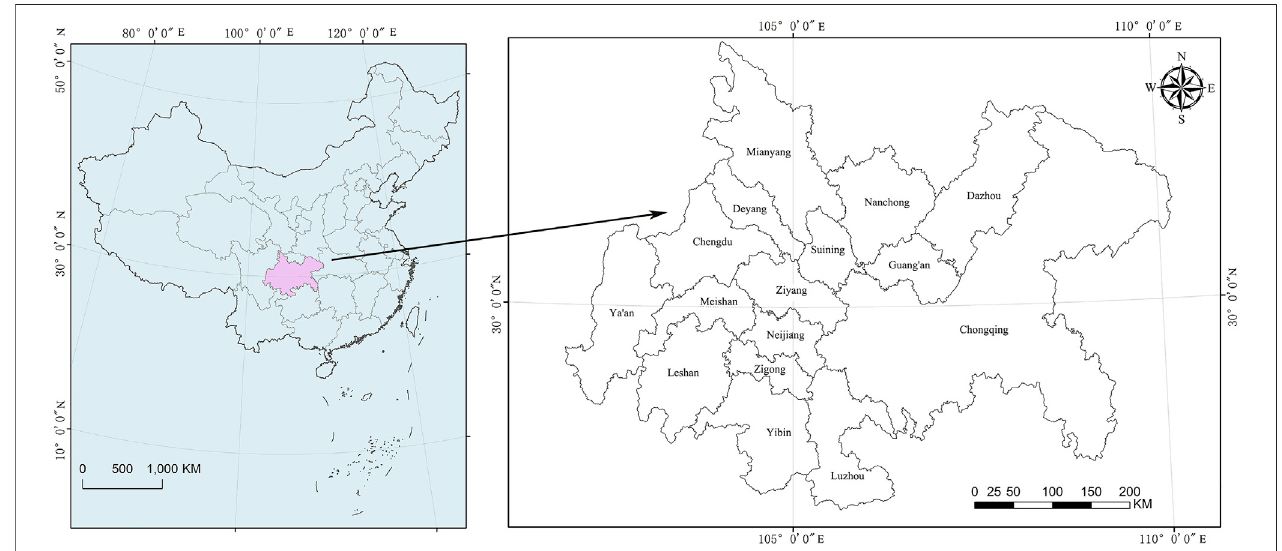
FIGURE 1 | Location and administrative division of the Sichuan